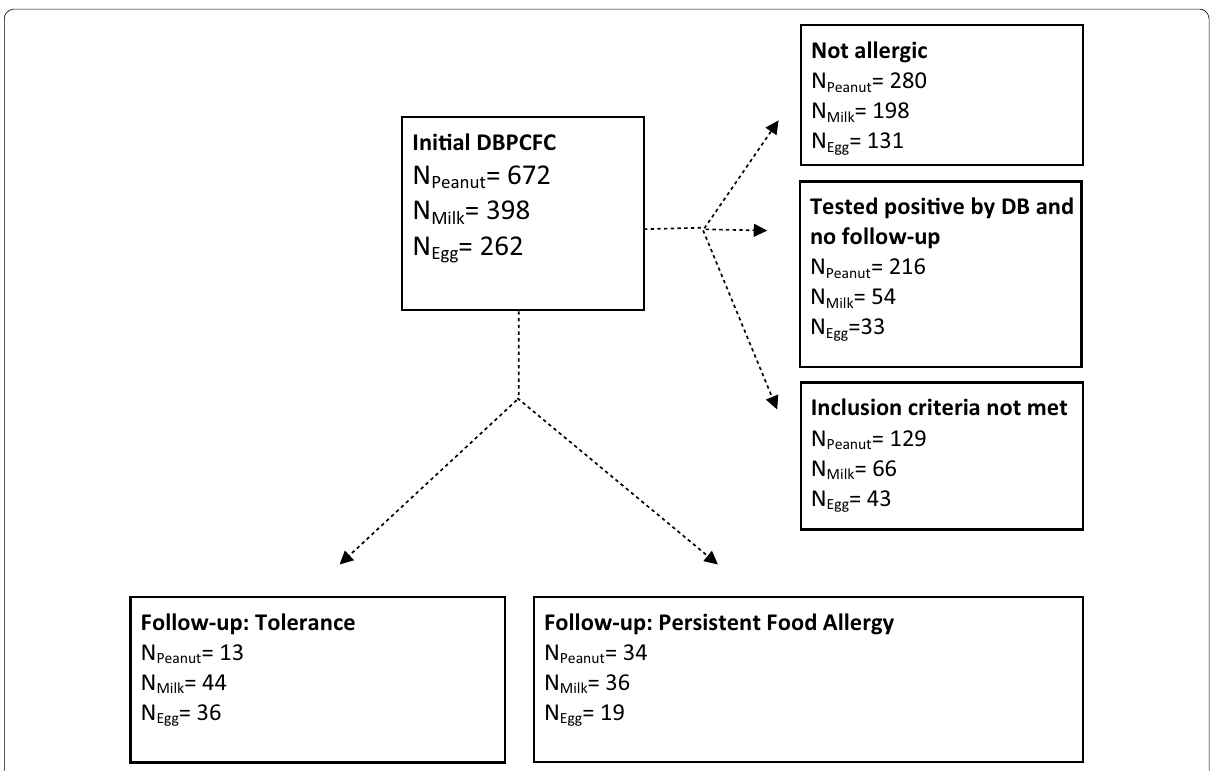
Fig. 1 Flowchart: selection procedure of children allergic to peanut, cow’s milk or hen’s